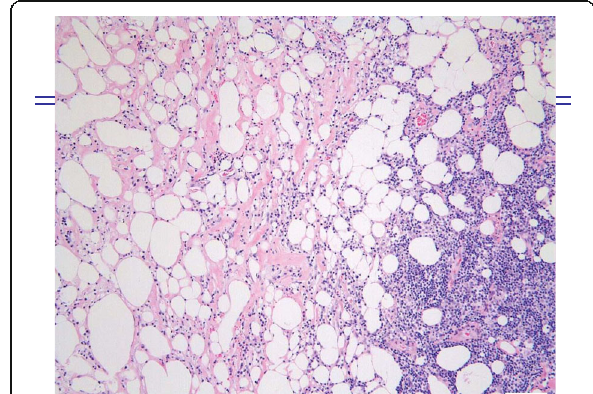
Fig. 3 Histopathology of a skin biopsy of the arm presenting septal and lobular panniculitis, with inflammatory infiltrate predominantly composed of lymphocytes in fat lobules and hyaline fat necrosis